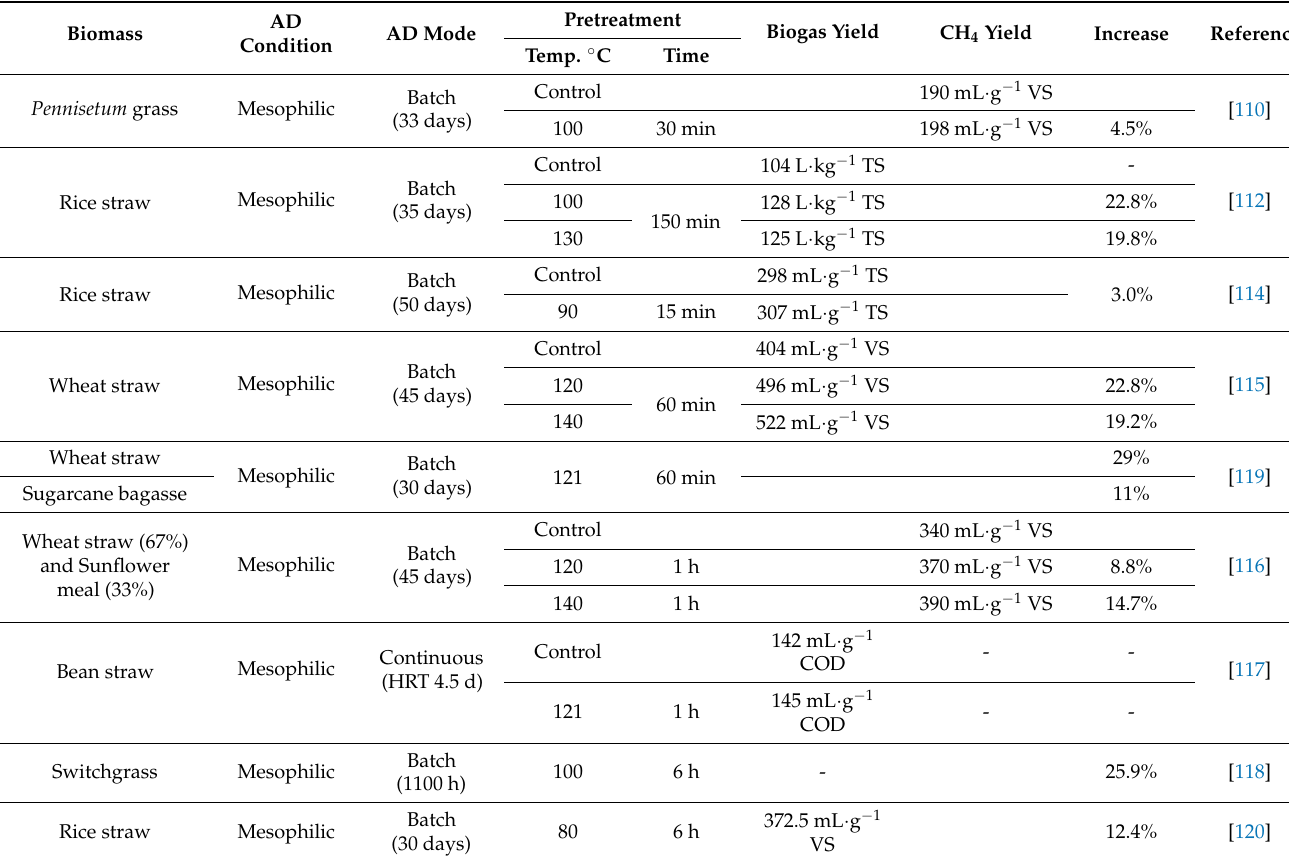
Table 6. Biogas production variation of lignocellulosic biomass after LTPT (Temp. ≤